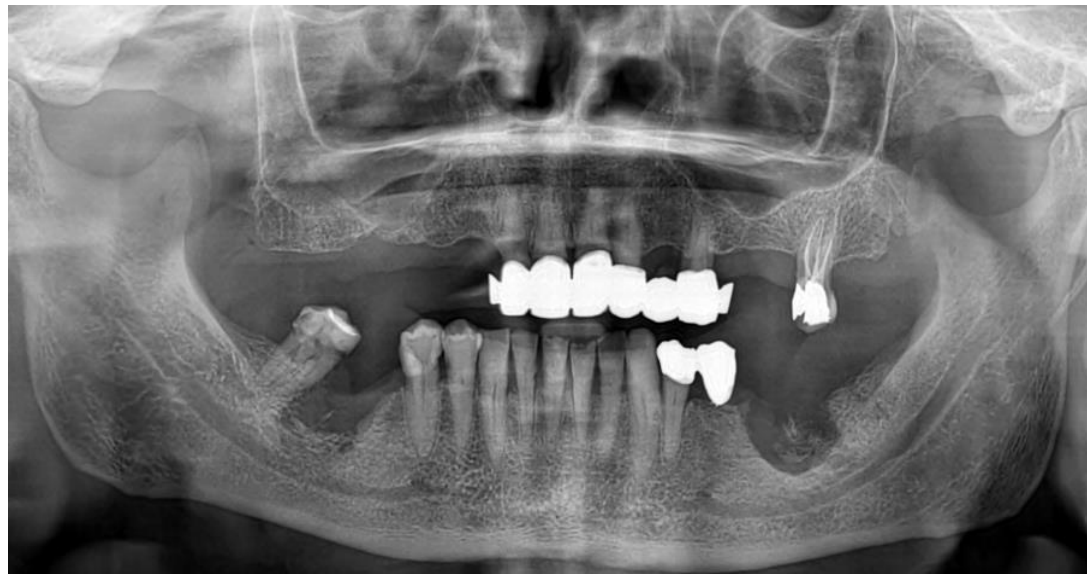
Figure 2. The panoramic radiograph showing the two regions affected by MRONJ. Clinical and radiographic signs oriented for a diagnosis of stage 2 (AAOMS staging) [13] bilateral MRONJ.